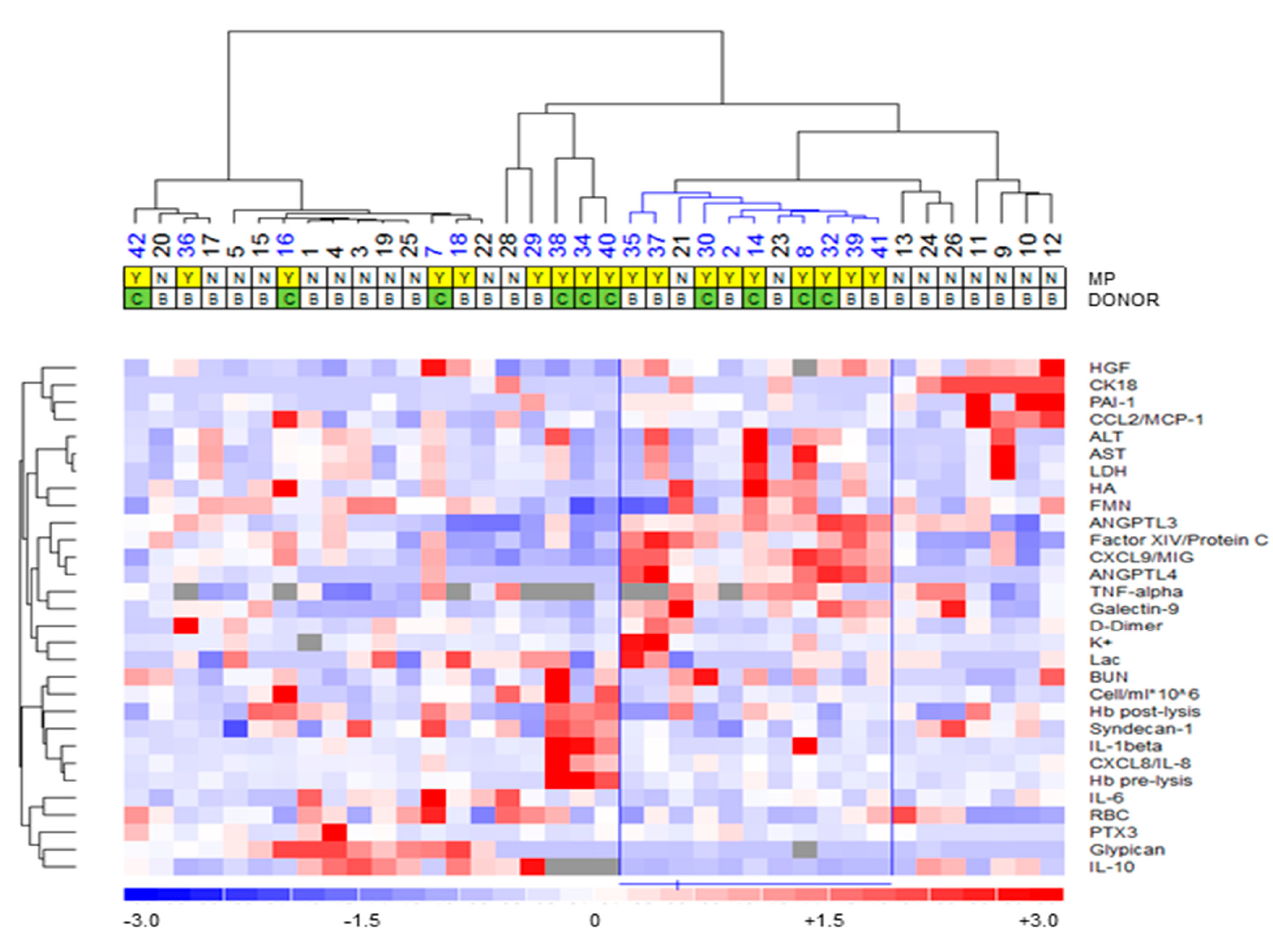
Figure 1. Agglomerative hierarchical clustering of molecular effluent profile of liver grafts. Unsupervised analysis was performed in order to investigate whether specific signature could be identified in the effluent fluids. A distinctive profile was recognizable, with 9 out of 18 grafts subjected to MP grouped in a single cluster ( p = 0.021). Cluster analysis was performed using dCHIP software (clustering method: average linkage; distance metric: 1–Spearman’s rank correlation). Columns identify liver grafts, while rows denote the parameters evaluated in effluent fluids. Y denotes “MP-yes”, while N denotes “MP-no”. Cause of death was referred to as D for DBD donors and C for DCD. The degree of color saturation reflects magnitude of variable concentration, as indicated in the color scale. ALT, alanine transaminase; ANGPTL3,